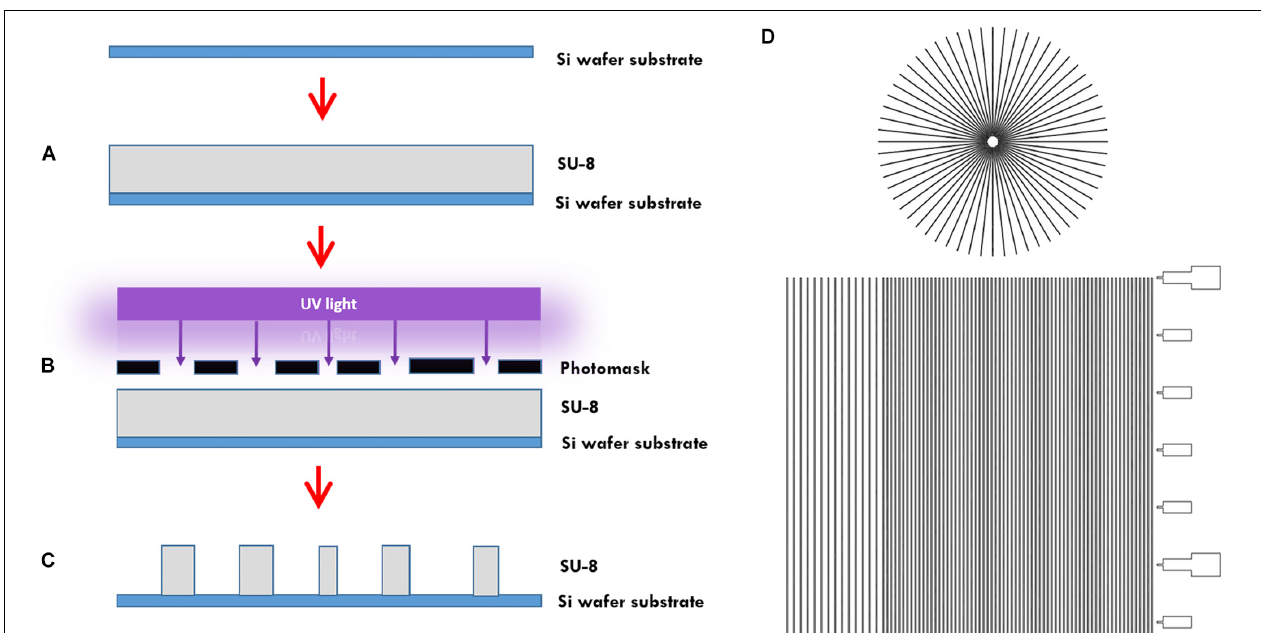
FIGURE 1 | Microtunnel device fabrication using photolithography. (A) A SU-8 2050 negative photoresist (SU-8) was spin coated onto a silicon wafer. (B) A mask was placed onto pre-baked photoresist and the components were subjected to a collimated UV light source. (C) After a post-bake, the wafer is placed in developer to clear away the soluble, unexposed photoresist. This leaves a detailed design of the mask in the photoresist on the silicon wafer that can be used as a master for use in creating microtunnel devices using soft lithography with polydimethylsiloxane. (D) Part of the design of the mask, showing both the microtunnels in a linear and radial configuration. A scale bar was added along the linear microtunnels, with ticks at a 500 µ m interval. Microtunnels were designed with a height of 5 µ m and a tunnel width of either 10, 15, and 20 µ m. The distance between the tunnels is either 50 or 100 µ